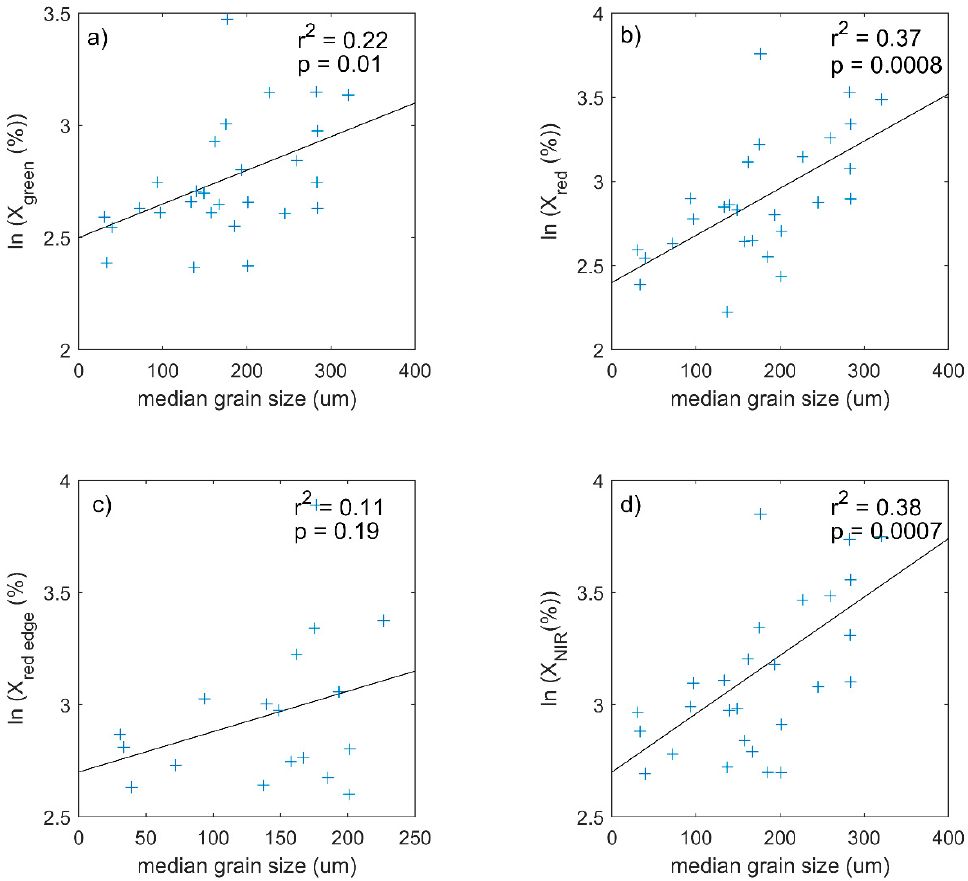
Figure 8. The relationship between median grain size and natural log of reflectance for the multispectral channels (+), the best-fit line is indicated in black: ( a ) green reflectance; ( b ) red reflectance; ( c ) red edge reflectance; ( d ) near-infrared reflectance. r 2 and p values for the correlations are given in the top right-hand corner of each graph.